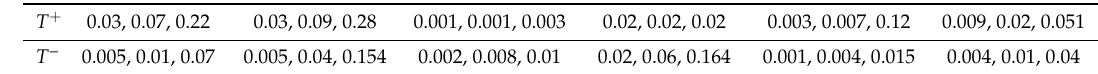
Table 13. Second part of FPIS and FNIS.